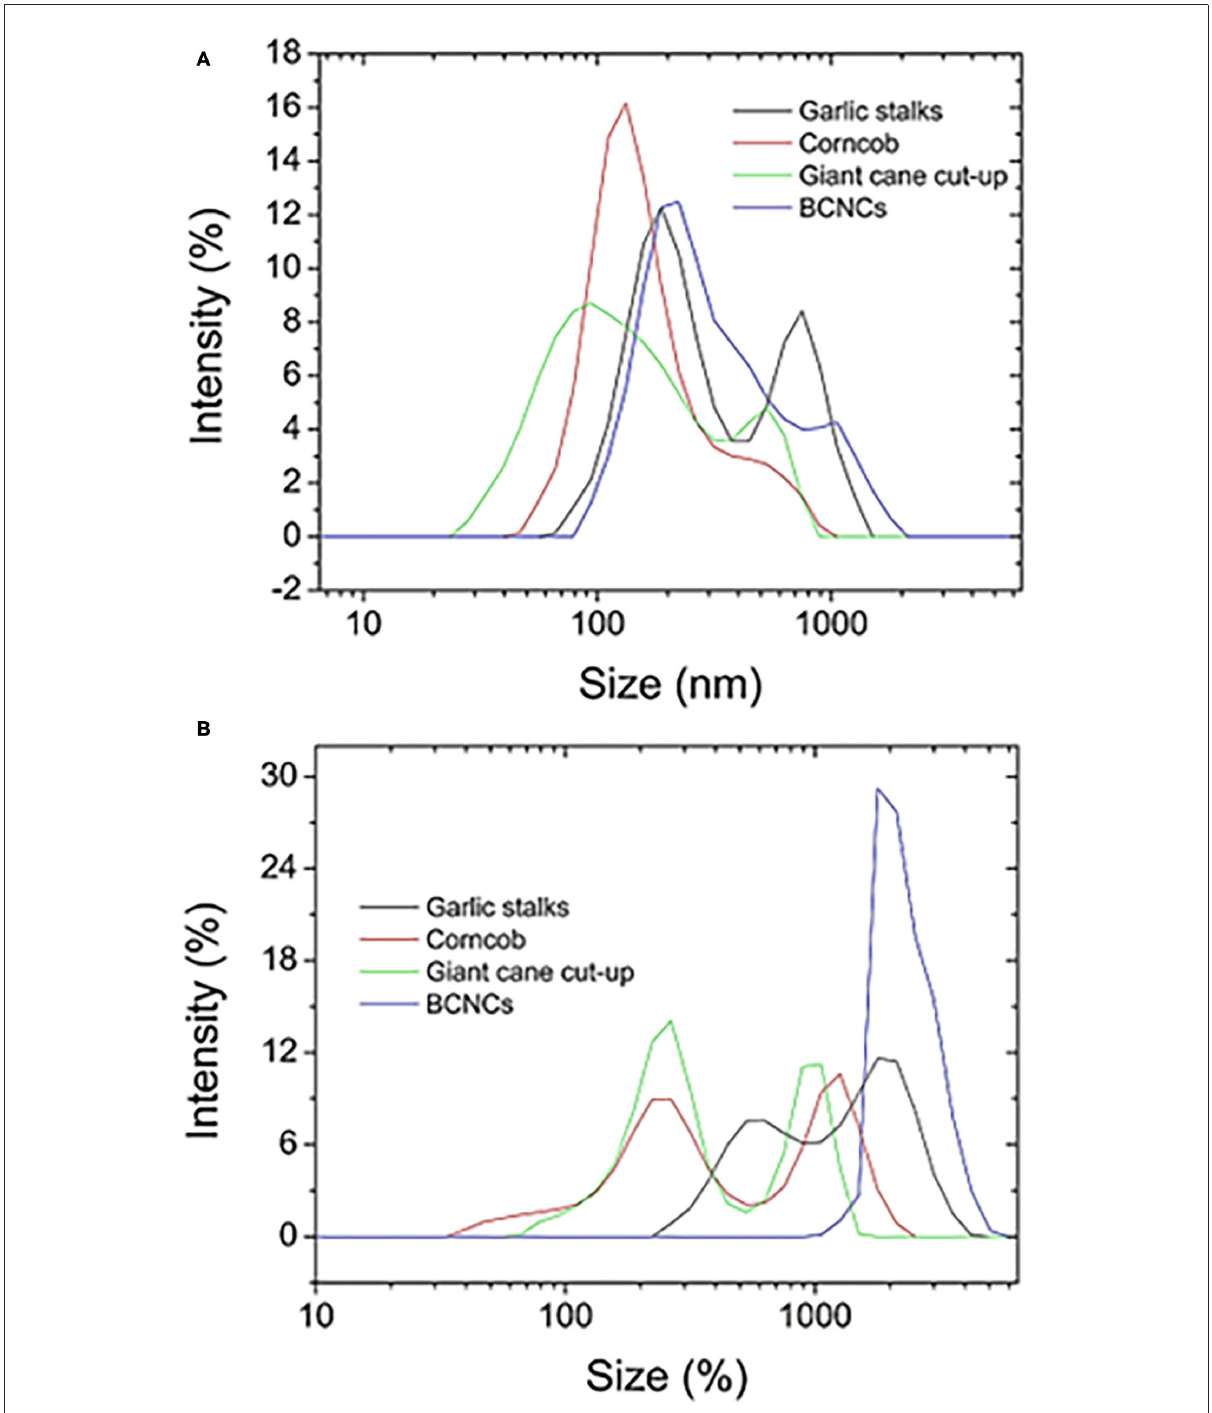
FIGURE7 Size distribution by DLS analysis of CNCs derived from garlic stalk, corncob, and giant cane cut-up biomasses after acid hydrolysis by sulfuric (A) and hydrochloric (B) acid. For comparison purposes, the size distribution of CNCs from acid hydrolysis of cellulose produced by K. sucrofermentans has also been